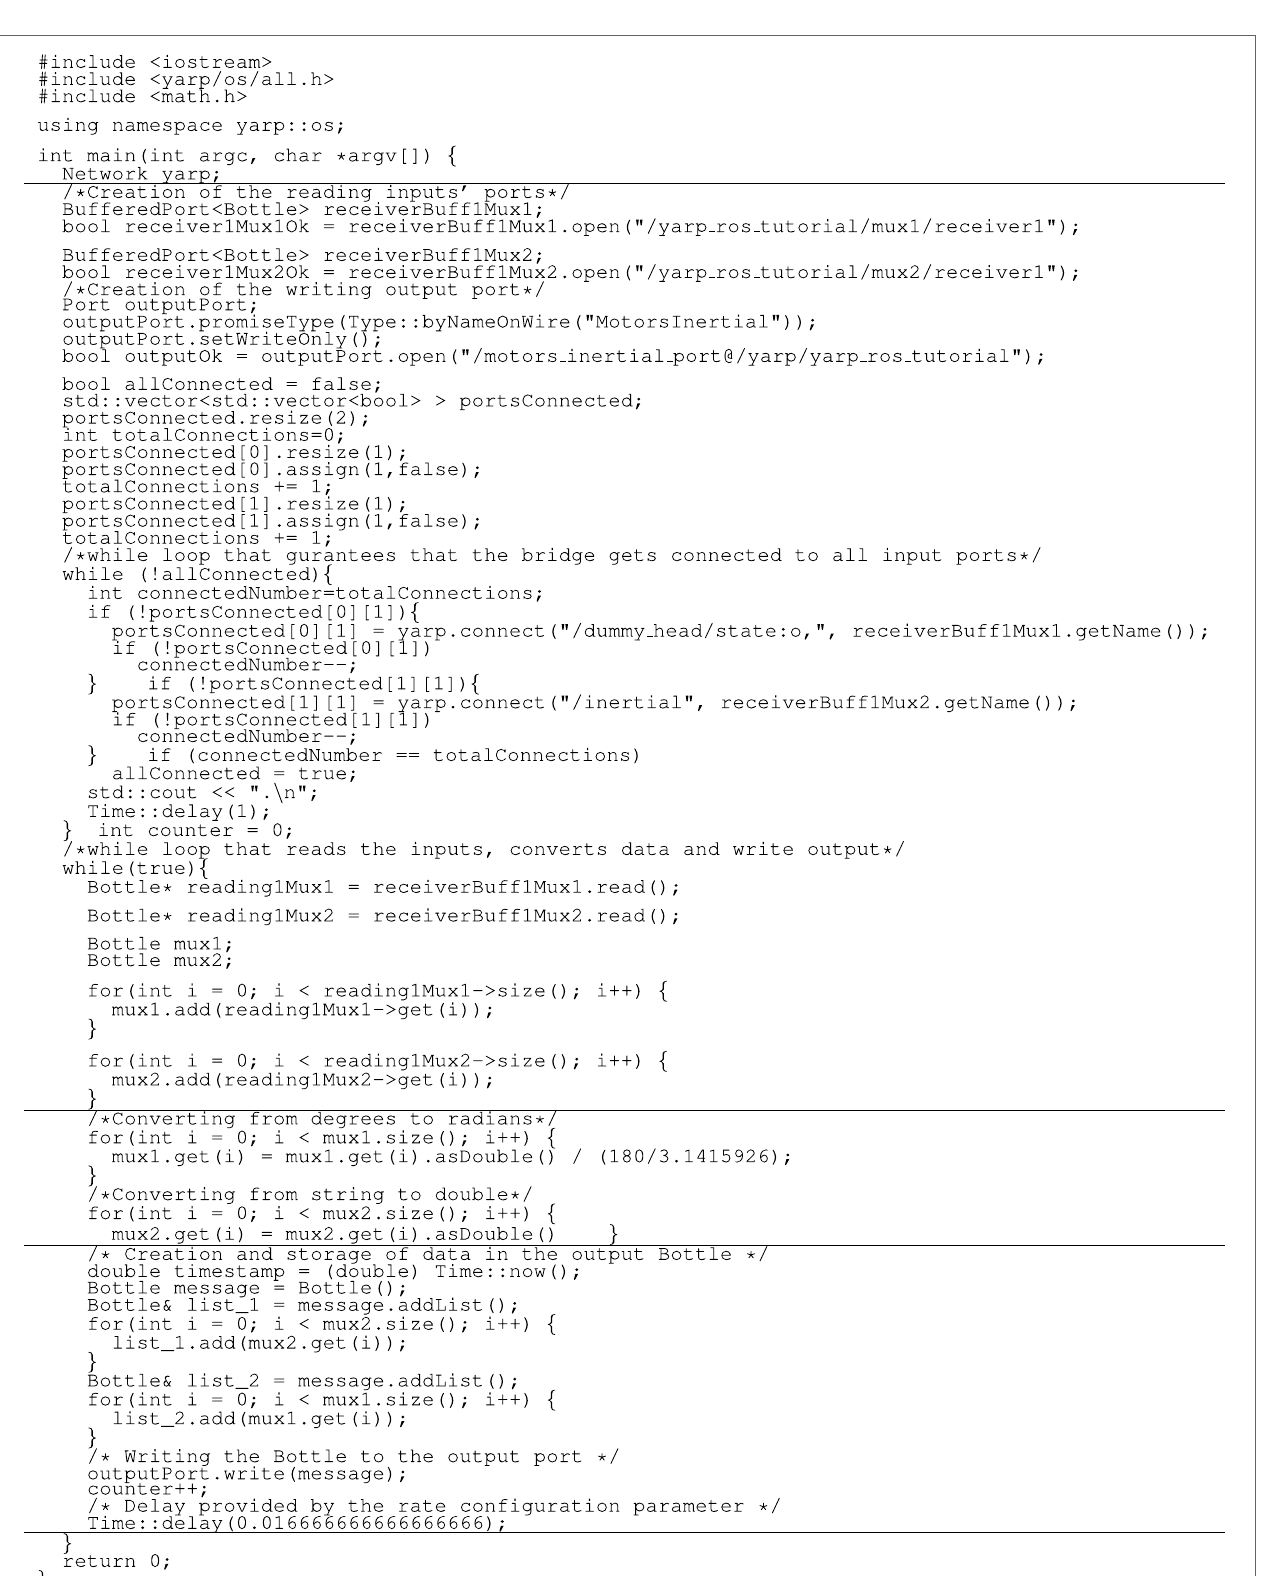
FIGURe 3 | example of the generated C ++ code by running the yarp-bottle-generator executable with the configuration file yarp_ros_tutorial example in Figure 2A